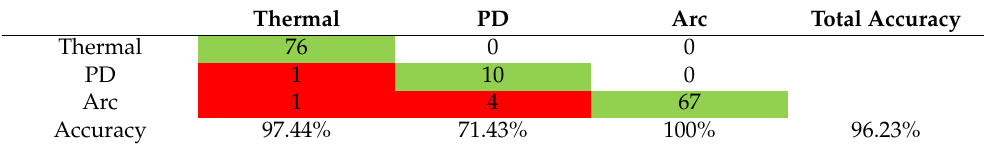
Table 7. Performance of the system with an SVM